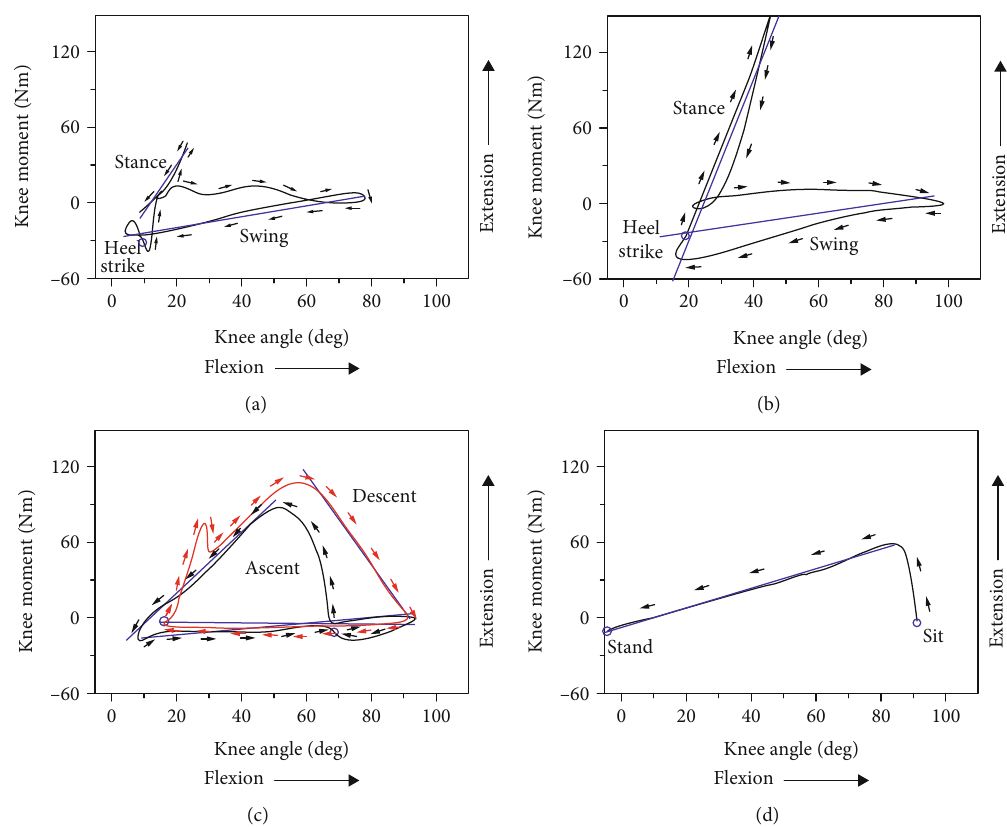
Figure 6: The moment-angle (sti ff ness) curves of the knee joint for normal walking, running, stair climbing, and sit-to-stand. (a) Normal walking [20, 34]. (b) Running [35, 36]. (c) Stair ascent and stair descent [24]. (d) Sit-to-stand